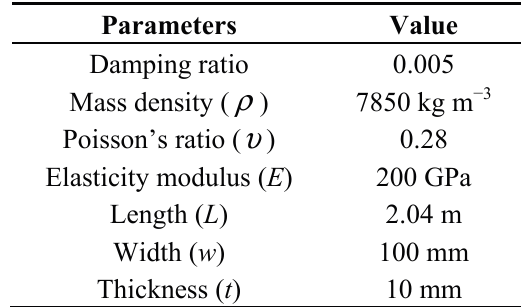
Figure 2. Schematics of the simply supported beam model and its damage scenarios. Table 1. Properties of the structural model used.